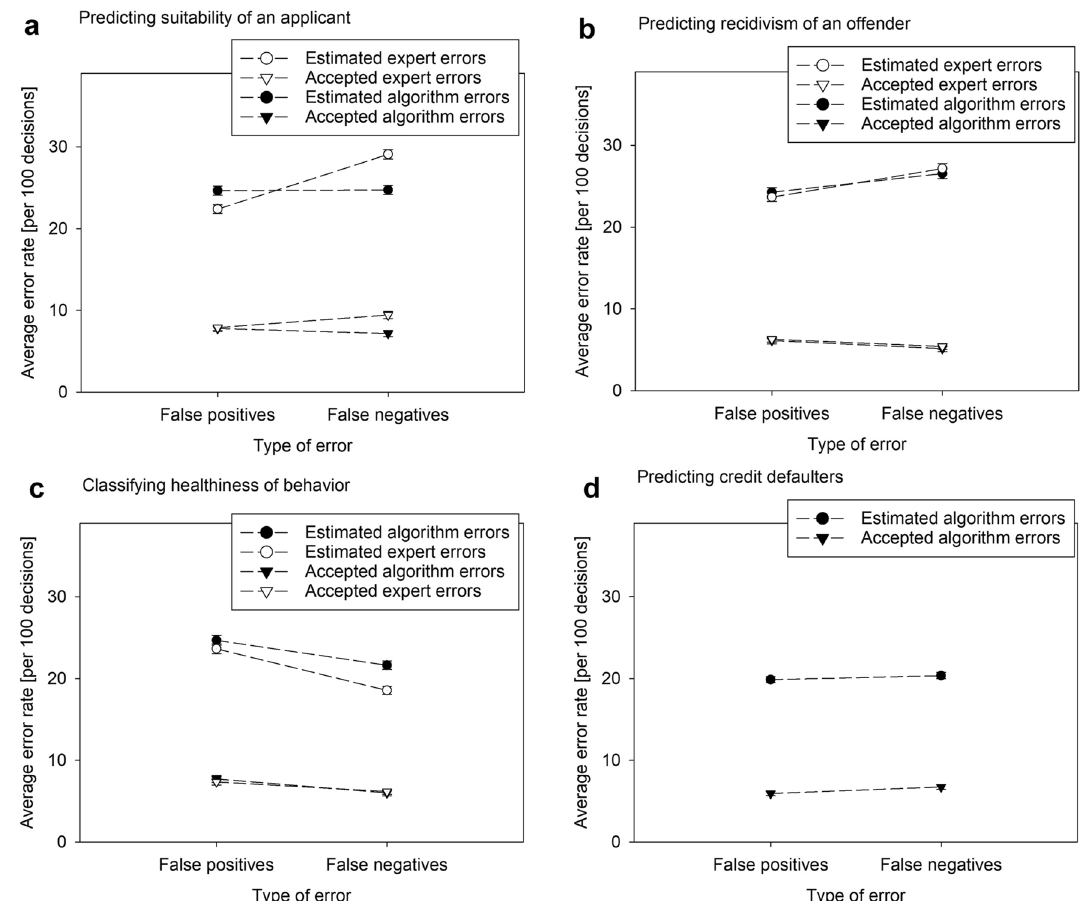
Figure 1. (a–d) Estimated and accepted rates of false positives and false negatives related to the assessments of job suitability ( a ), recidivism ( b ), and health behavior ( c ) by algorithms and experts, and to credit scoring ( d ). Data are weighted for representativeness. Error bars show the standard errors of the mean. For predicting credit defaulters, estimates of expert errors were not elicited.